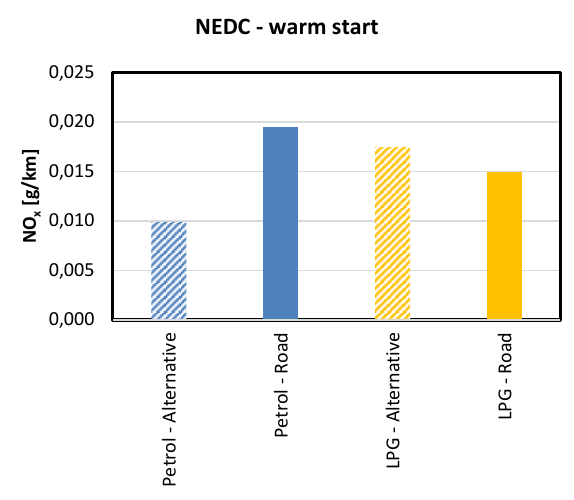
Fig. 15. Impact of resistance forces on NO x emissions for NEDC tests